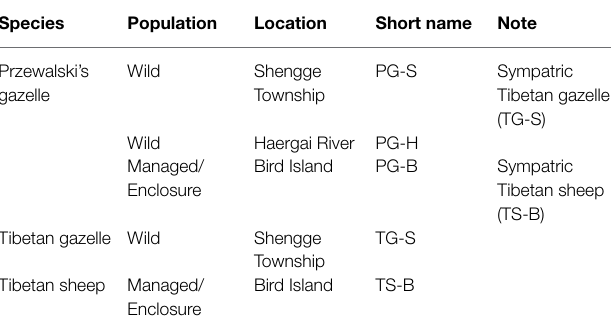
TABLE 1 | Information on study animals and their